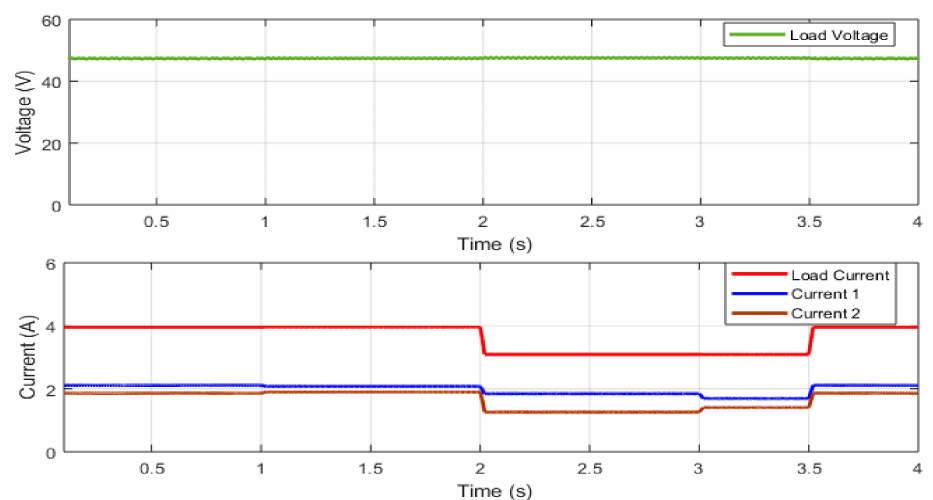
Figure 11. Simulation results for variation in source voltage and load with different cable resistances for novel droop control: load voltage, converter output currents and load